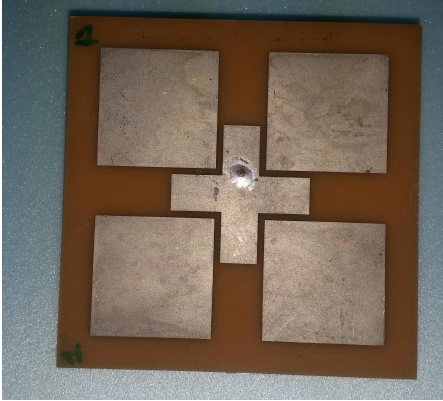
Figure 2. Photo of one of the realized antennas.